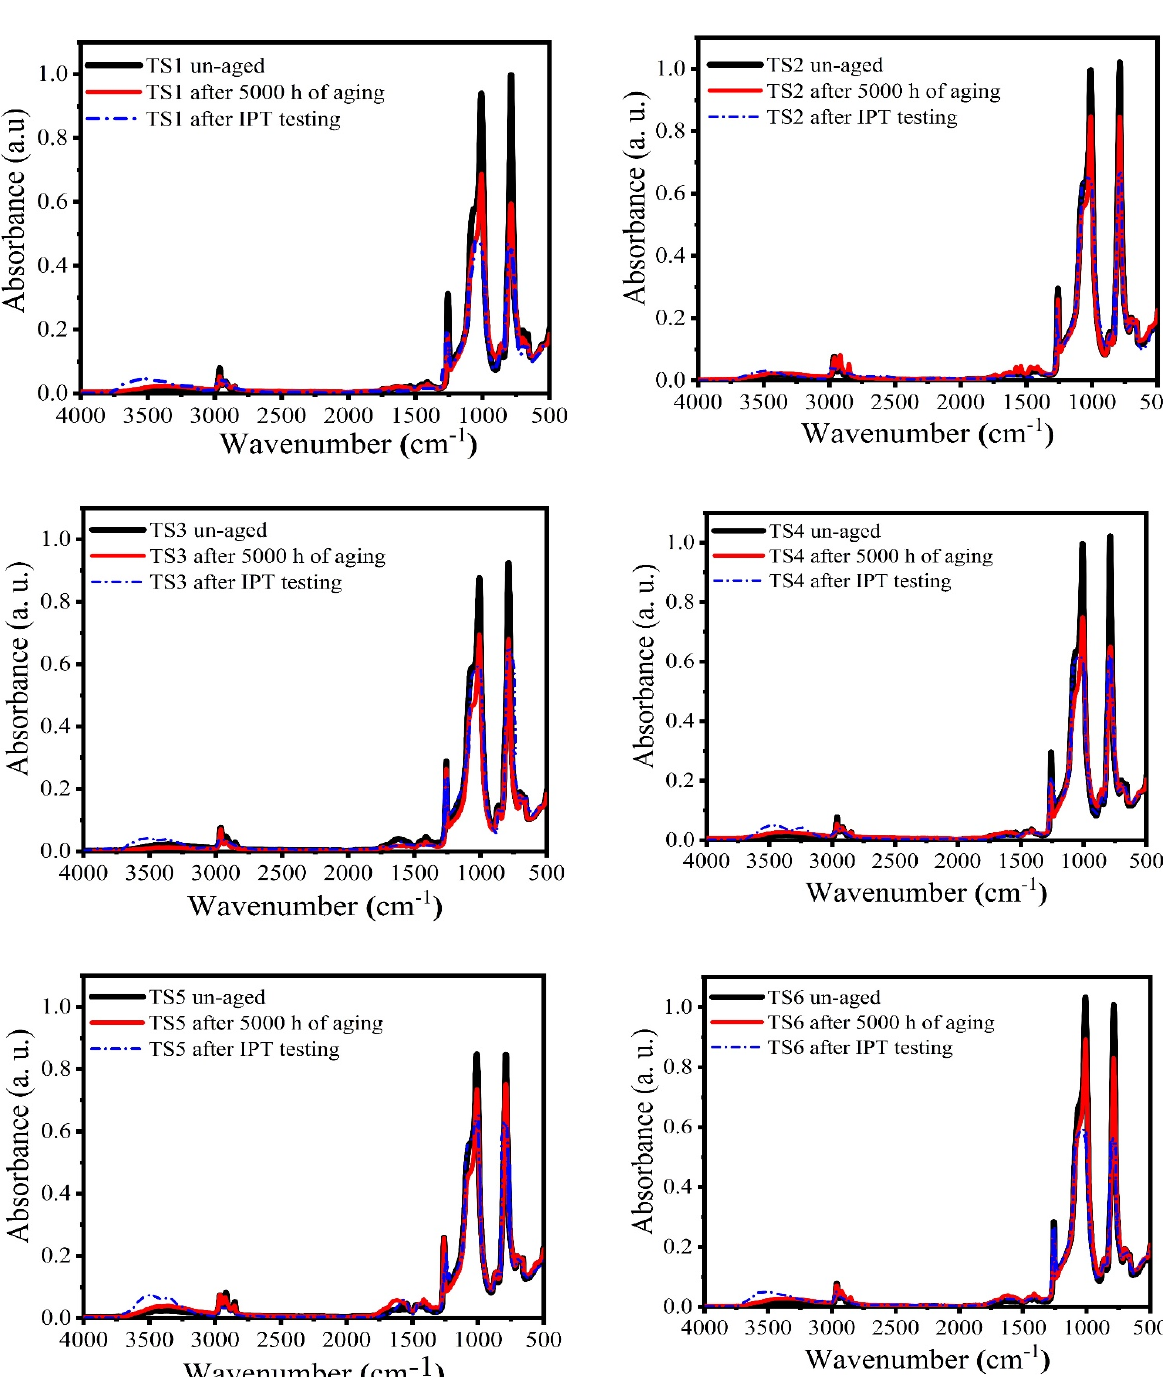
Figure 14. FTIR analysis of the test samples in unaged, aged and aged + IPT conditions.